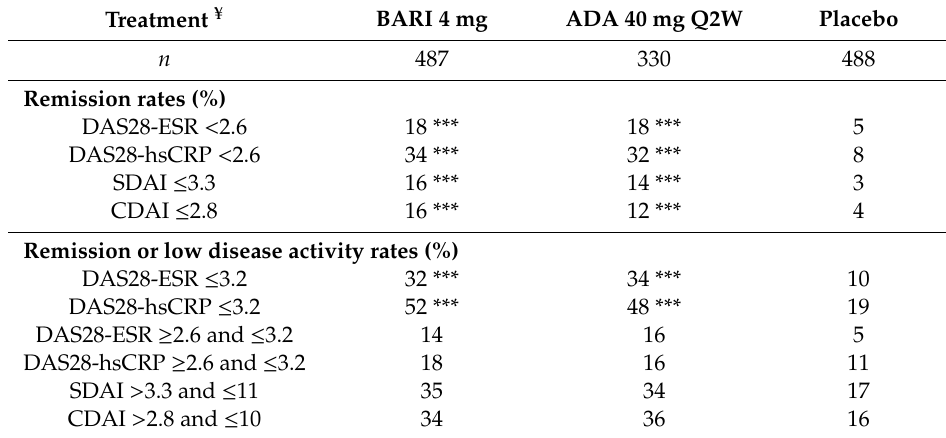
Table 1. Remission and remission or low disease activity rates at week 24 in patients with moderately to severely active rheumatoid arthritis from RA-BEAM [14,20]. Treatment ¥ BARI 4 mg ADA 40 mg Q2W Placebo n 487 330